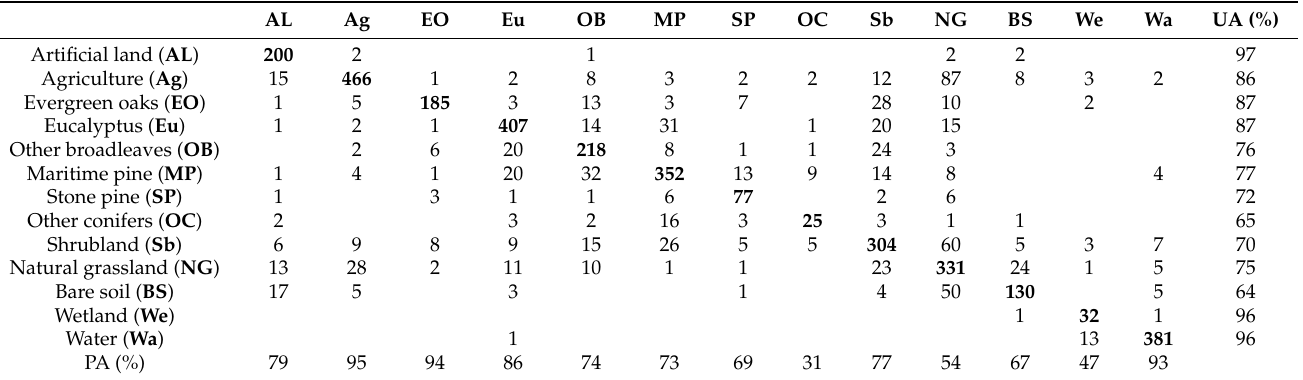
Table 3. Global confusion matrix. The matrix entries express pixel counting to facilitate